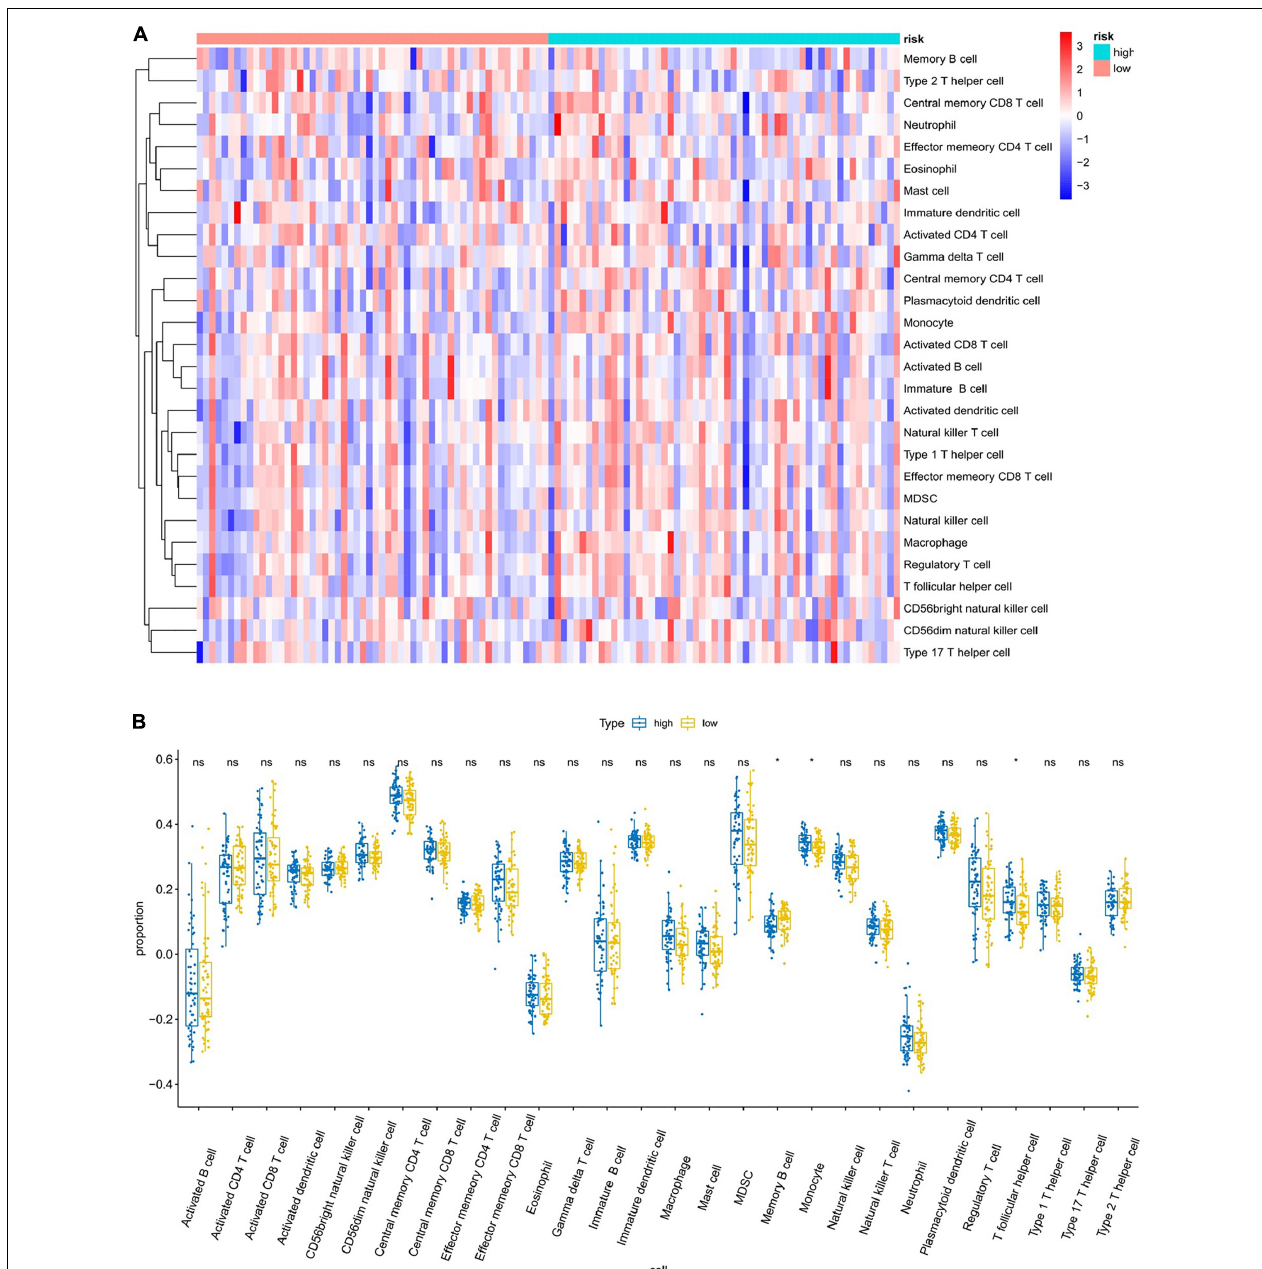
FIGURE 9 | Analysis of immune infiltration patterns in breast cancer samples from TCGA dataset via an ssGSEA score-based method. “ns” represents that there is no significant difference in the infiltration of immune cells between the two samples; “*” represents P < 0.05. (A) Heatmap of ssGSEA scores (red = positive, blue = negative). (B) Boxplot of ssGSEA scores of the 28 representative gene